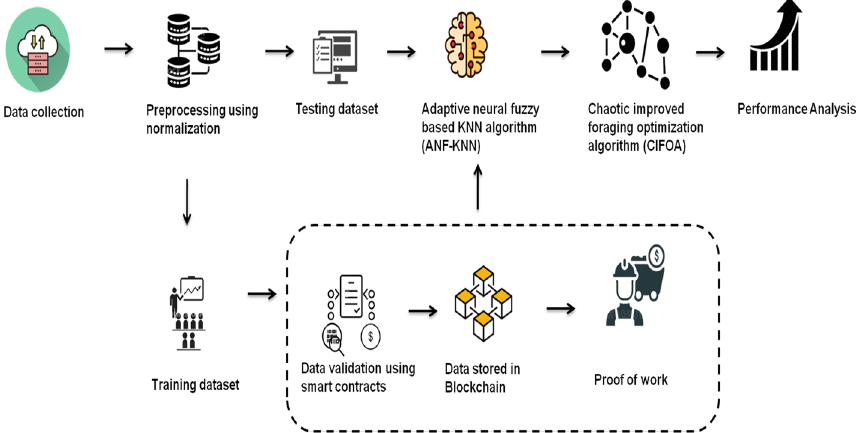
Fig. 2 Overall representation of the proposed